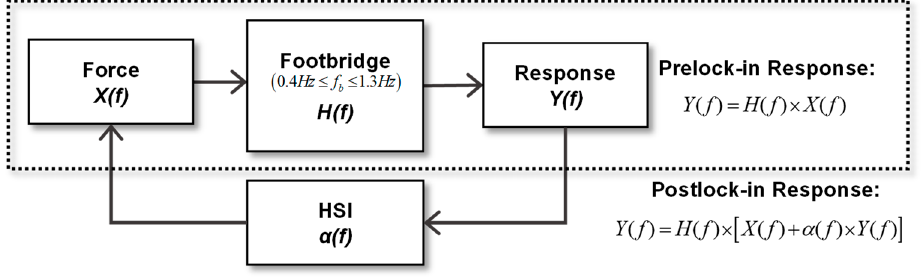
Figure 2. Feedback system to model human–structure interaction